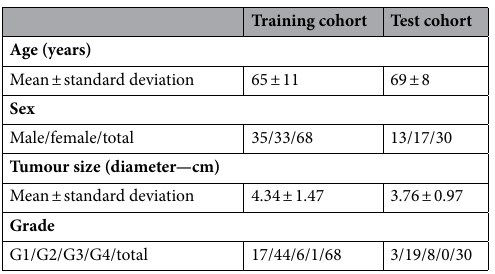
Table 1. Demographic information of training and test cohorts 8 .